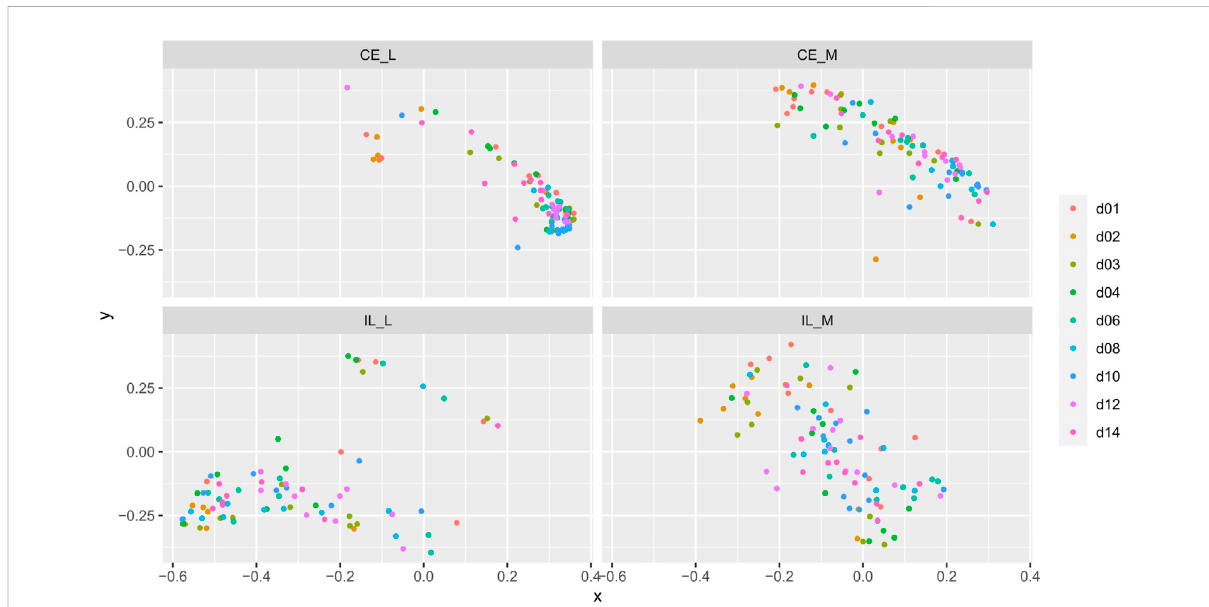
FIGURE 5 Comparison of beta-diversities. Principal coordinates analysis of Bray-Curtis matrices of each day within each site. Community structures signi fi cantly differed across